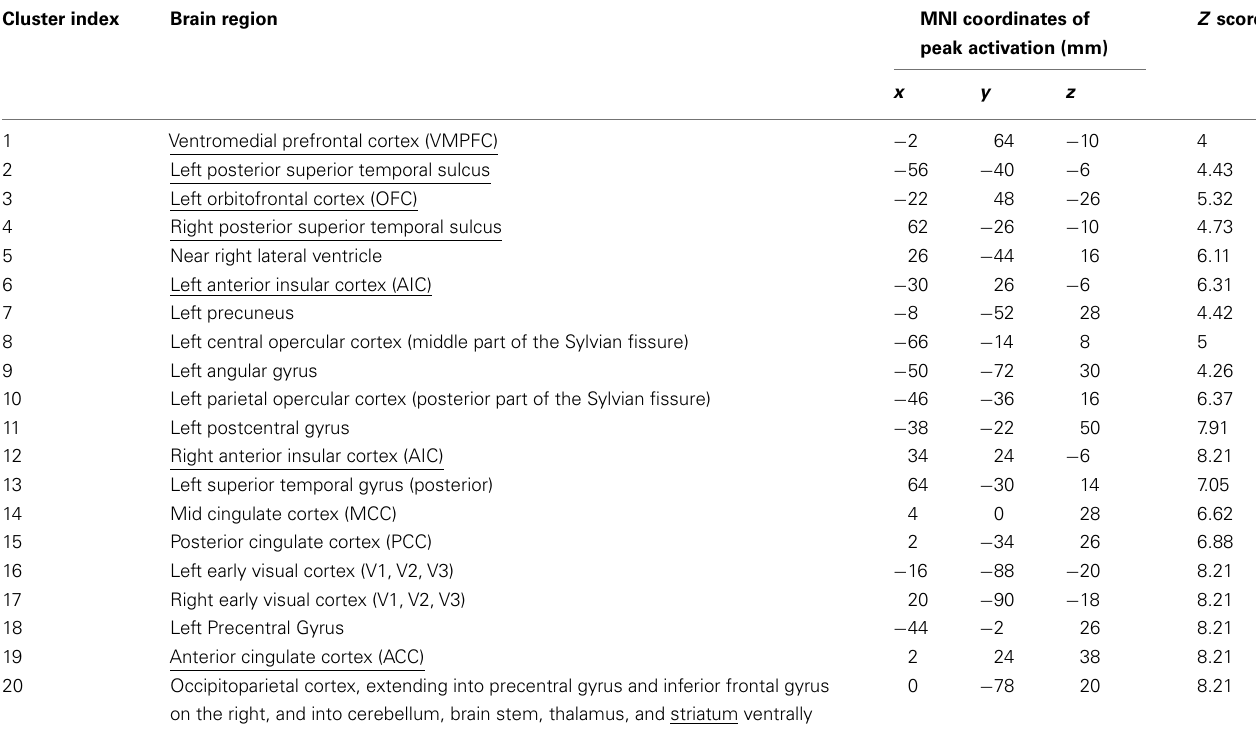
Table 3 | Locus of peak activations in clusters resulting from an F -test over the 24 trials from the (averaged) pre- and post-interaction DOT ( Z > 3.1, cluster size > 40).